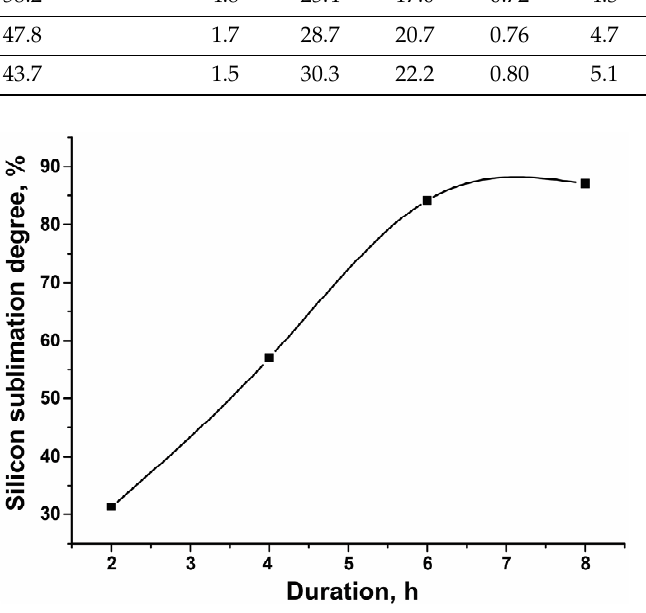
Figure 4. The dependence of the degree of sublimation of silicon from silicon dust of electrofluorination of ilmenite concentrate during fluorination.